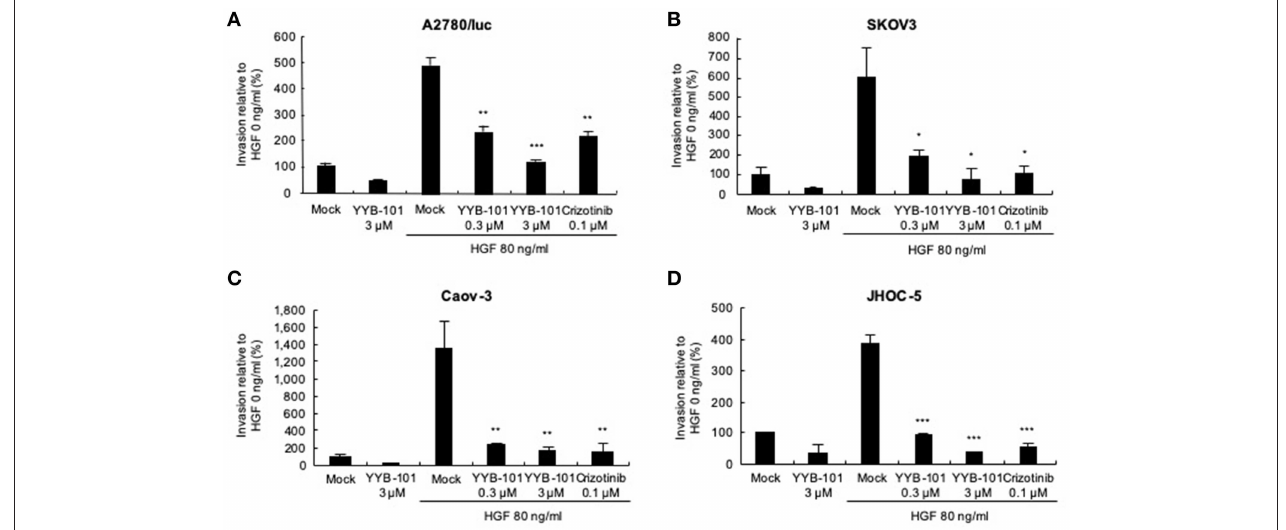
FIGURE 3 | Effect of YYB-101 on invasion of ovarian cancer cells. (A) A2780/luc (2 × 10 5 ), (B) SKOV3 (0.5 × 10 5 ), (C) Caov-3 (1.5 × 10 5 ), and (D) JHOC-5 (1.0 × 10 5 ) cells were seeded onto Matrigel-coated upper chambers. Lower chambers contained 3 µ M YYB-101, 80ng/mL hepatocyte growth factor (HGF), 80ng/mL HGF